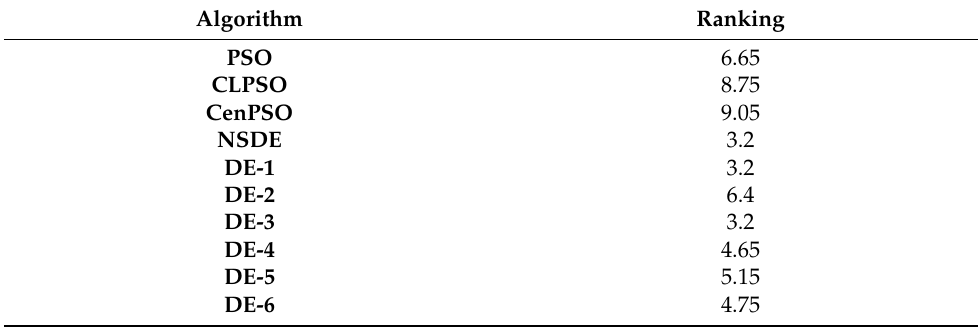
Table 19. Average rankings of the ten algorithms obtained by Friedman test for NP = 50. Algorithm Ranking PSO